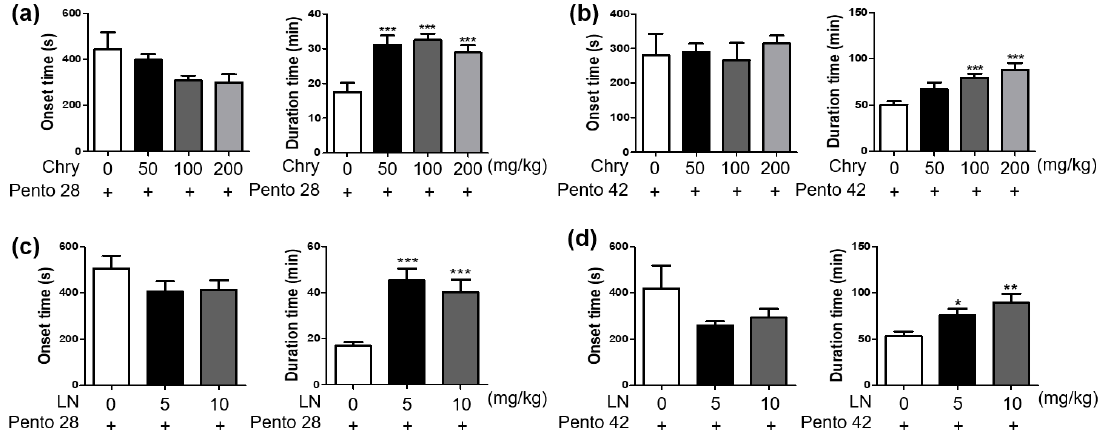
Figure 2. Effects of Chry and linarin on sleep onset and sleep duration in pentobarbital-treated mice. The experiment design; mice were fasted for 24 h before the experiment, and Chry ext or linarin was administered at each concentration 1 h and 25 h before the intraperitoneal administration of pentobarbital. Sleep onset and sleep duration were assessed. The results of Chry ext tested at pentobarbital subhypnotic ( a ) and hypnotic ( b ) concentrations are displayed. The results of linarin tested at pentobarbital subhypnotic ( c ) and hypnotic ( d ) concentrations are displayed. Data are expressed as mean ± SEM. * p < 0.05, ** p < 0.01, and *** p < 0.001, compared with the pentobarbital only group.